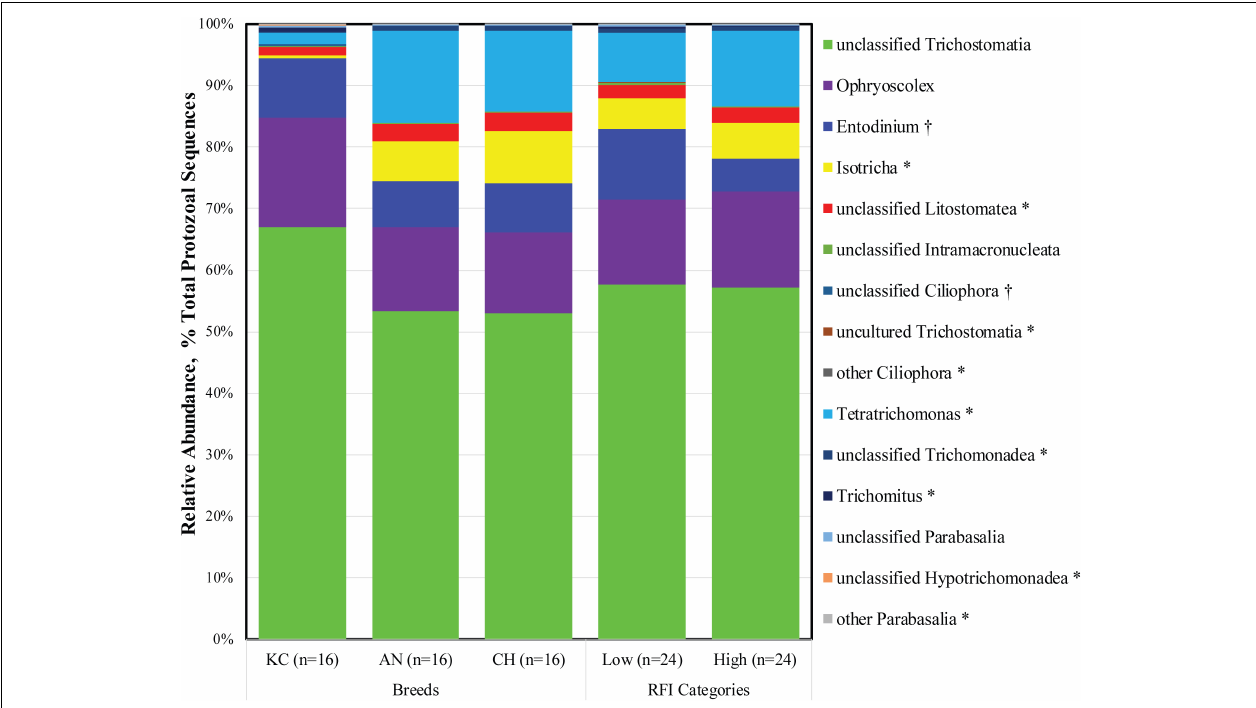
FIGURE 2 | Active rumen protozoal composition at the genus level in beef cattle of three breeds and with divergent residual feed intake (RFI). Taxa name with asterisk (*) represents significant breed effect ( P < 0.05), and taxa name with dagger ( † ) represents significant RFI effect ( P <